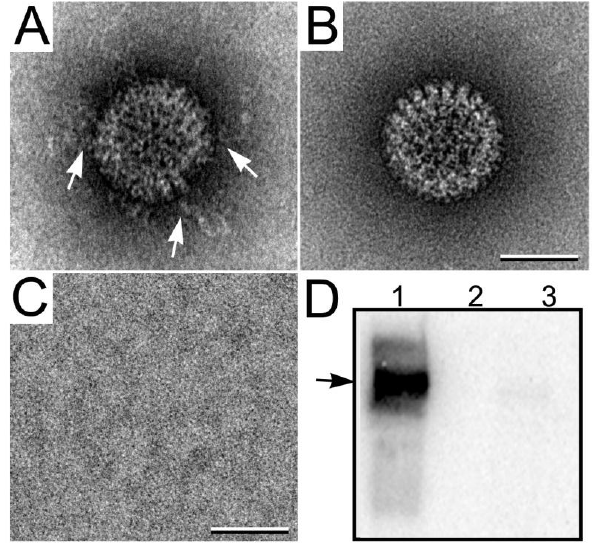
Figure 6. ( A ) Representative image of a transcriptionally active rotavirus DLP producing thin strands of RNA transcripts (white arrows). ( B ) Representative image of an assembly lacking ATP in the transcription mixture that failed to produce visible strands of